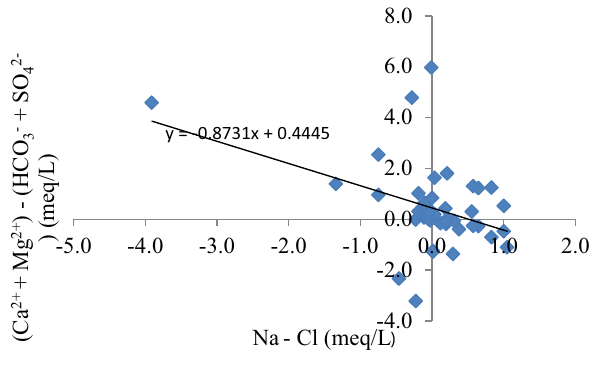
Fig. 11 The stability of anorthite (plagioclase) and its possible sec- ondary weathering products gibbsite, kaolinite and Ca-montmorillon- 3 + SO 4 (meq ite with respect to groundwater within the Asutifi-North